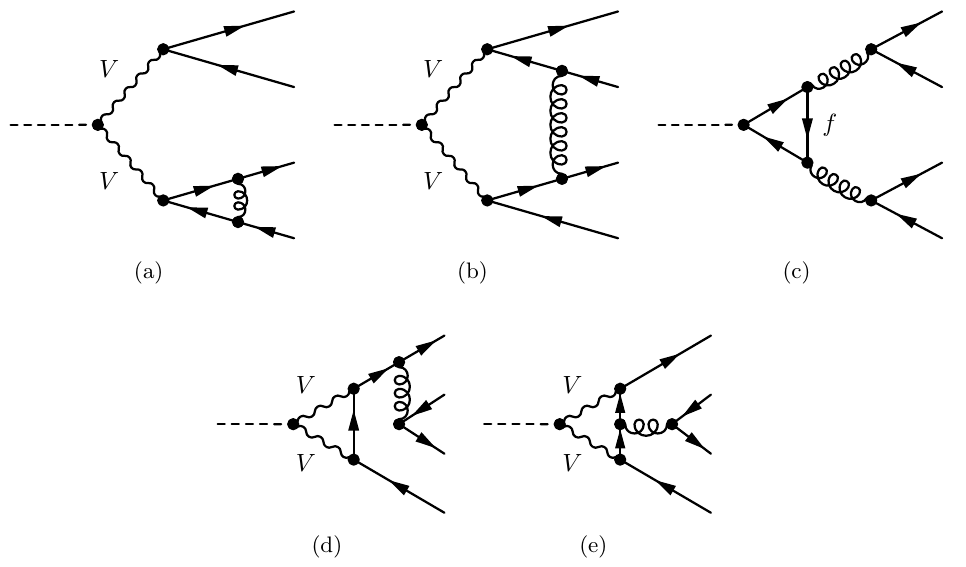
Figure 3 . Exemplary diagrams for the one-loop virtual QCD corrections. In the semi-leptonic case, only the (cid:12)rst diagram type exists. Only the interference of the last four diagrams with the crossed LO diagram of (cid:12)gure 1(b) has a non-vanishing colour structure, demanding the quarks to be